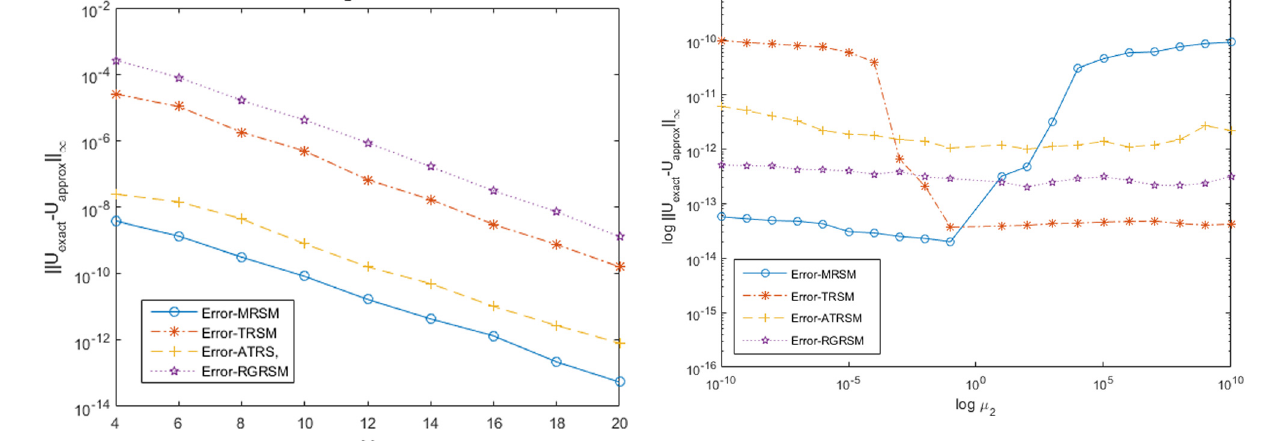
Figure 8: The absolute error of Example 4.2 by RSMs with t